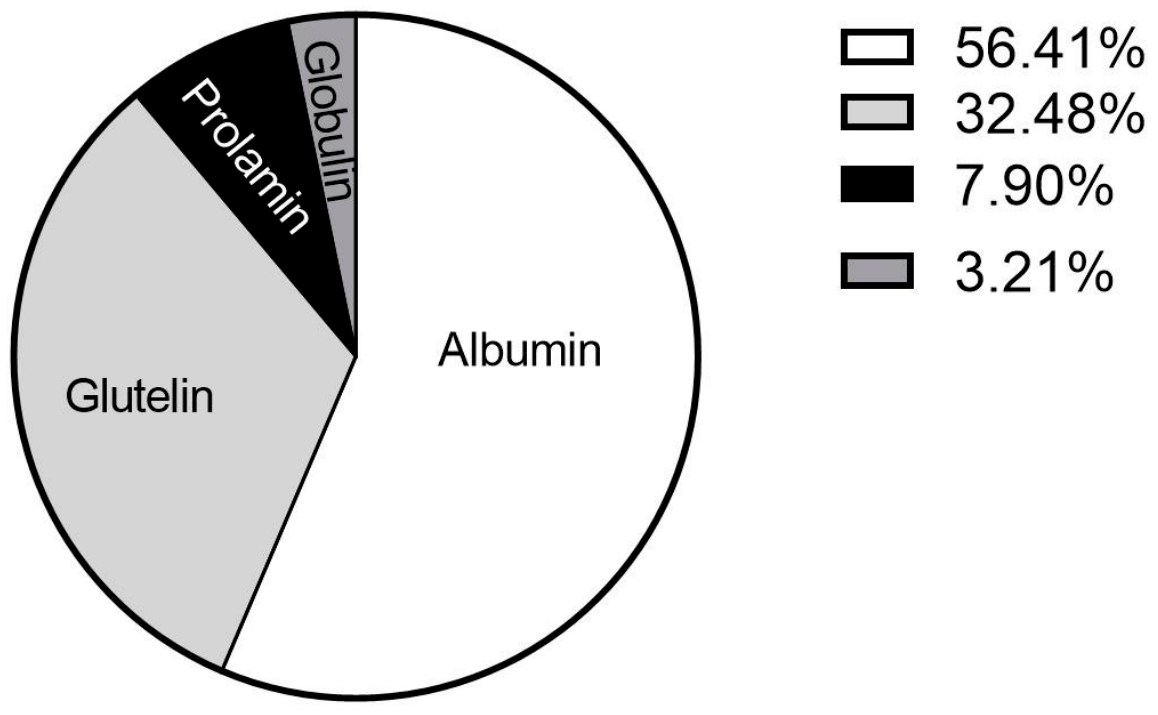
Figure 3. Osborne’s Classification of proteins of original powder. Table 1. Proximate analysis, recovery and characterization of cricket powder and